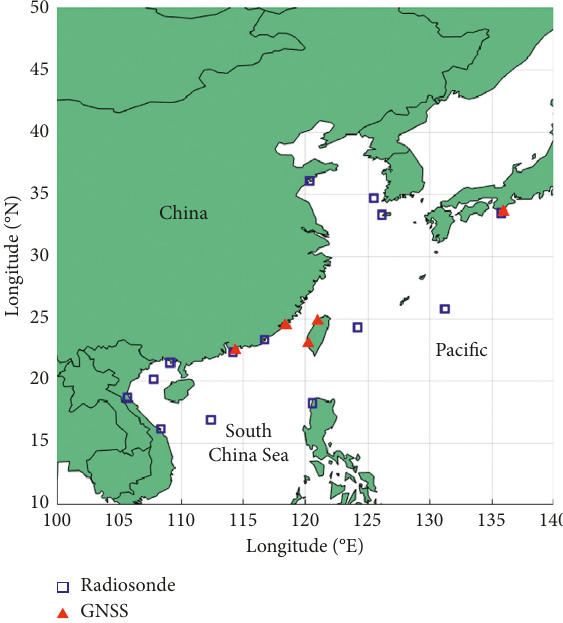
Figure 1: Geographical distribution of the 14 radiosonde and 5 GNSS stations selected for this study. The selected stations are located at either the coastal region or the